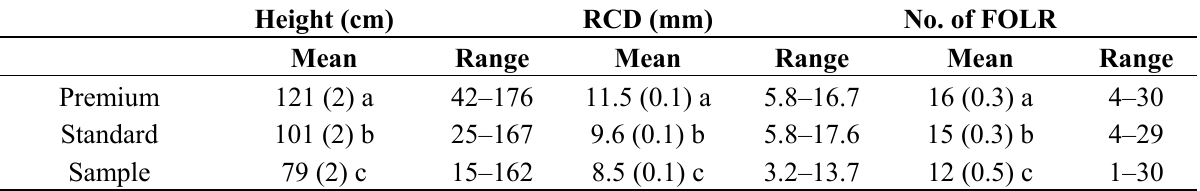
Table 1. Least-squares means, followed by standard errors, and ranges of stem height, root-collar diameter (RCD), and number of first-order lateral roots (FOLR) for two seedling grades and a random sample of 1–0 bare-root northern red oak nursery seedlings. Means followed by the same letter are not significantly